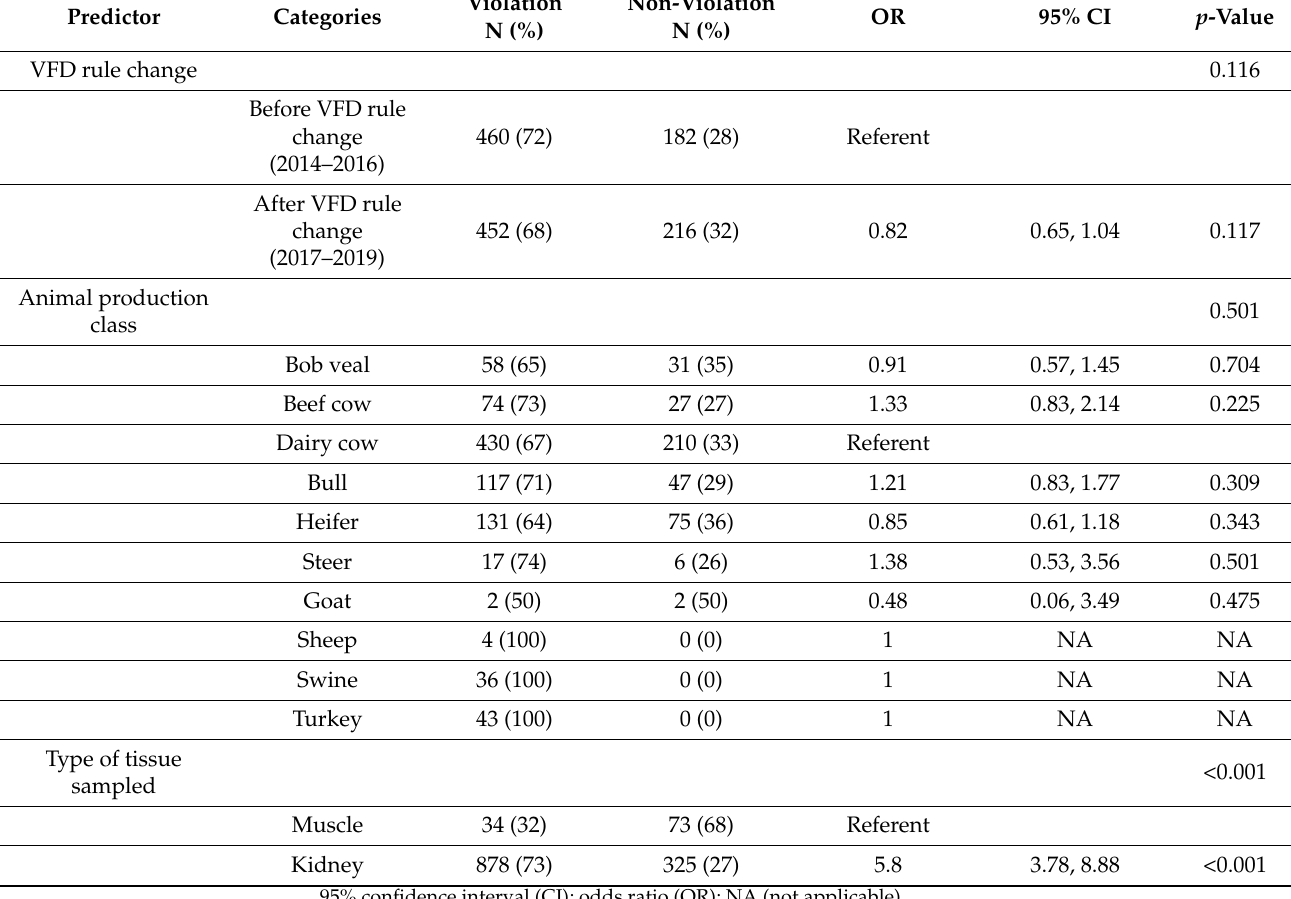
Table 1. Univariable association between predictors and detection of violative residues of penicillin in the tissue of food animals ( n = 1310) from the IGS,